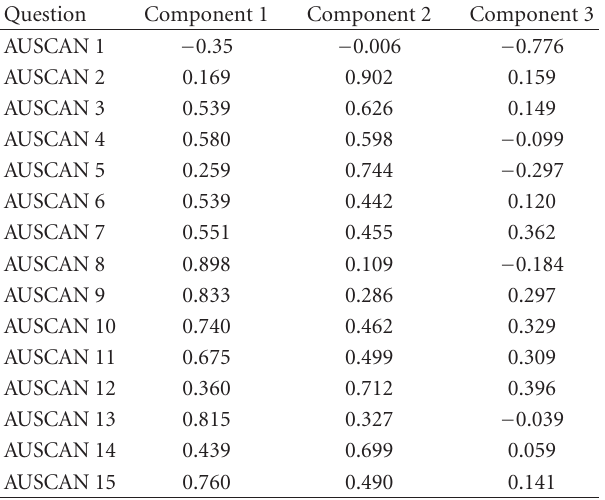
Table 7: Principal component analysis of the AUSCAN items. Rotated component matrix (item